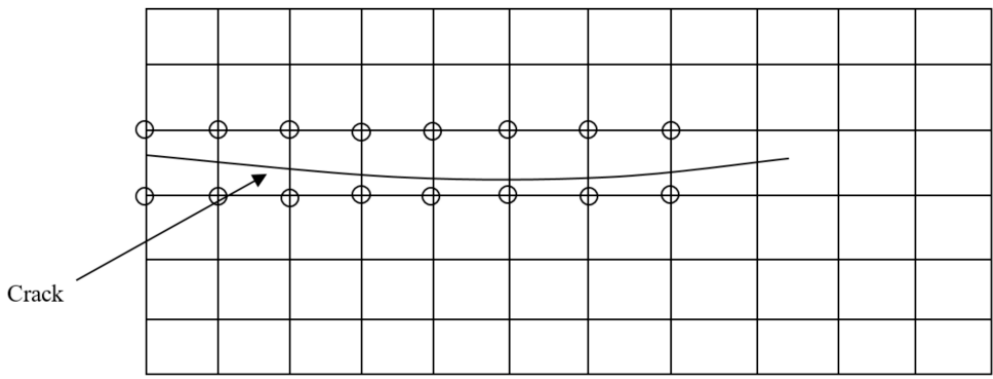
Figure 3. An arbitrary finite element mesh with a discontinuity (circles represent the enriched nodes of the mesh).